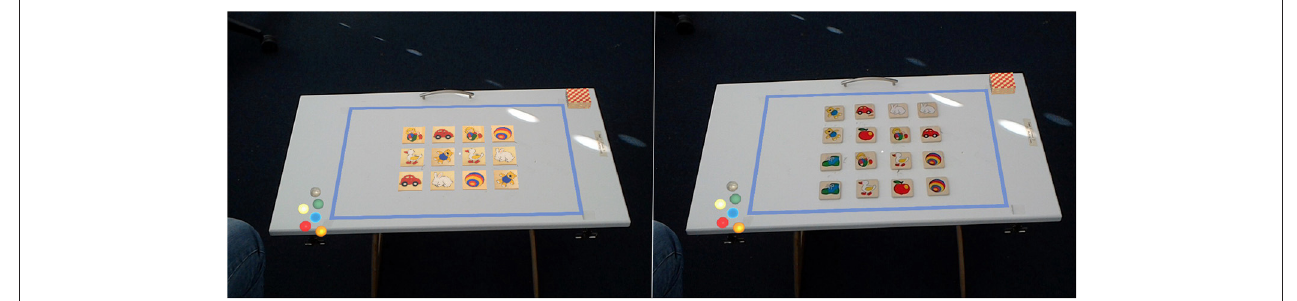
FIGURE 3 | The pairs-task: screenshots from the HoloLens showing the setup of the game. Virtual marbles and a deck of cards are always visible. On the left image the pairs cards are virtual, on the right image the cards are real. Taken from Vortmann et al. (2021).